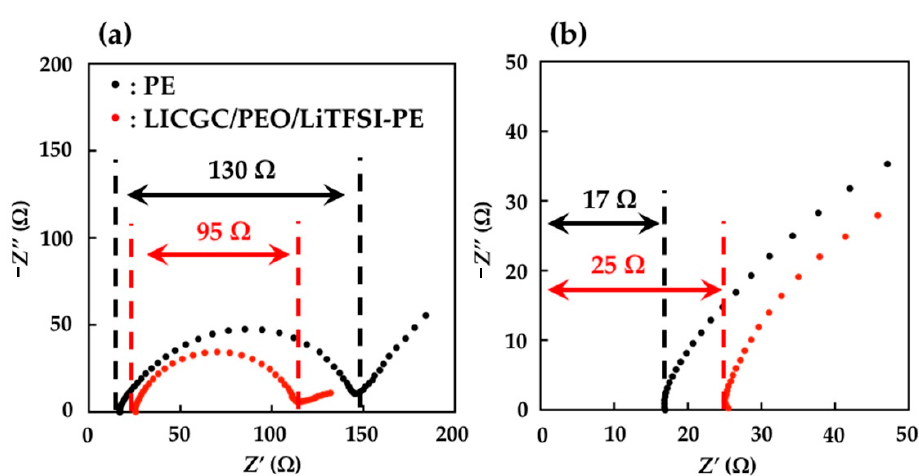
Figure 4. Nyquist plots of the impedance spectra for Li/Li symmetric cells using PE and LICGC/PEO/LiTFSI-PE separators. ( a ) Overview of the impedance spectra and ( b ) expanded spectra in the high-frequency region.